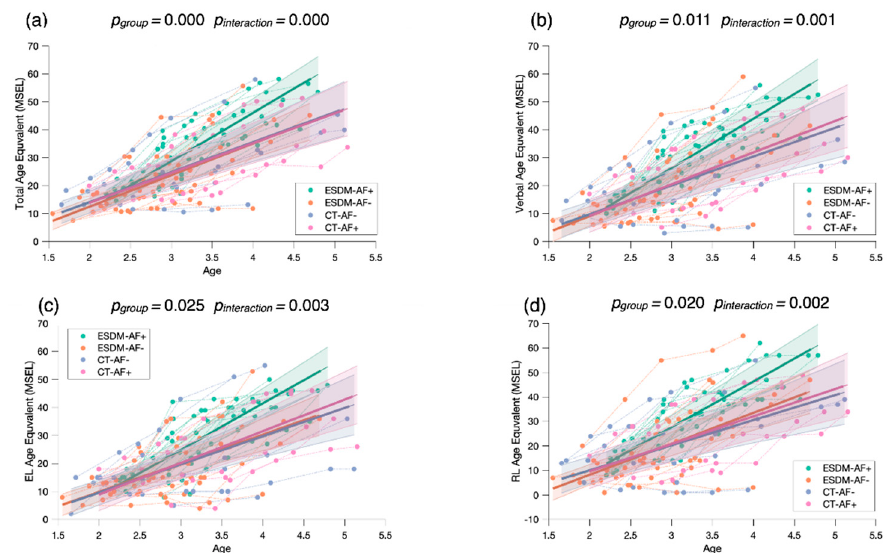
Figure A3. Mixed model regression analysis for the MSEL Total Age Equivalent ( a ), Verbal Age Equivalent ( b ), Expressive Language Age Equivalent ( c ), and Receptive Language Age Equivalent ( d ) for 265 longitudinal recordings from 52 young children with ASD (2.51 ± 0.45 years old) with lower or higher social orienting at baseline and who either received an early and intensive intervention ( ESDM-AF+; ESDM-AF- ) or community treatment ( CT-AF +; CT-AF- ). The group-level trajectory (bold line) is derived from mixed-effect modeling [43–45]. The 95% confidence interval is indicated by the colored bands around the estimated group-level trajectory.